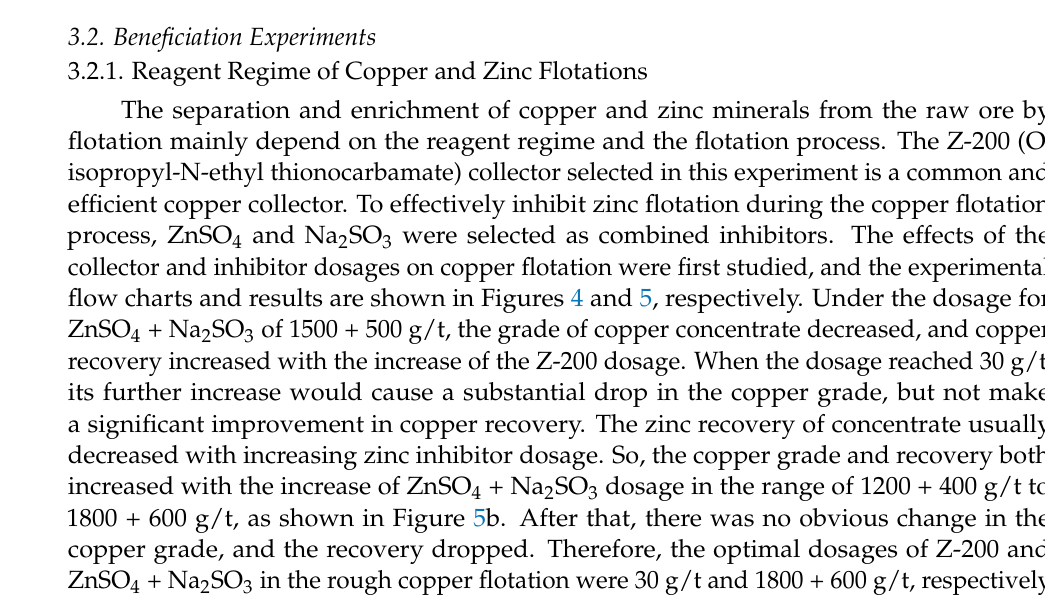
Figure 5. Effects of Z-200 ( a ) and ZnSO 4 + Na 2 SO 3 ( b ) dosages on copper flotation. Next, the effects of the dosages for the collector butyl xanthate (BX) and the activator CuSO 4 on zinc flotation were investigated based on the flow charts in Figure 6, where the feed was copper flotation tailings, and the results are shown in Figure 7. It can be con- cluded from Figure 7a that the recovery and grade of zinc concentrate both increased with the increase of BX dosage in the range of 60–80 g/t, and when beyond this range they were reduced. Thus, the optimal BX dosage was 80 g/t in rough zinc flotation. From Figure 7b, when CuSO 4 dosage was less than 500 g/t, the zinc grade and recovery both increased with increase in the dosage. After 500 g/t, the recovery did not increase signif- icantly, and the grade declined. So, the optimal dosage of CuSO 4 in rough zinc flotation was 500 g/t.